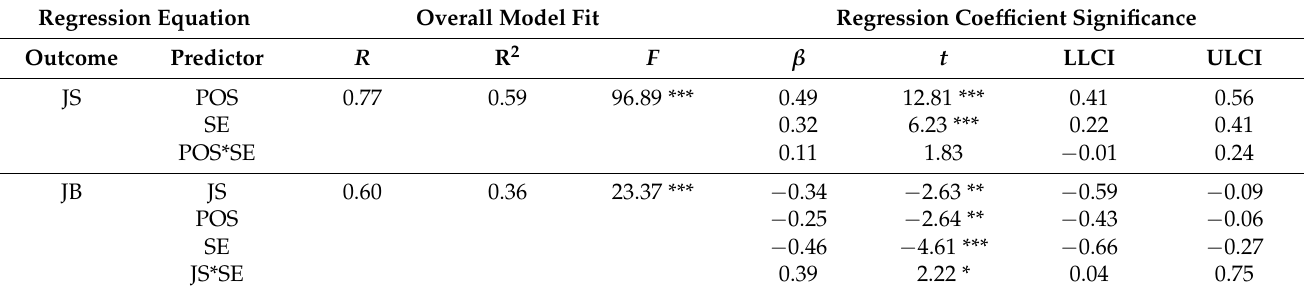
Table 9. Results of the moderating effect of self-efficacy on the mediating role of job satisfaction in the relationship between perceived organizational support and job burnout.